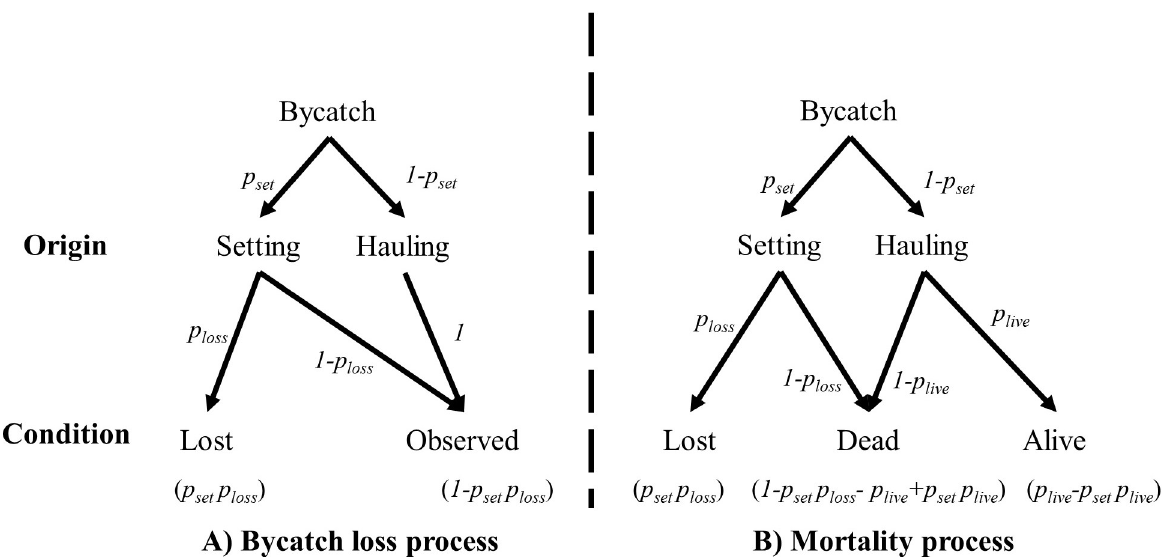
Fig 3. Two-step processes for both the bycatch loss (A) and mortality (B). The probability for each stage is in italics, and the probabilities of final outcomes can be found in parentheses under each